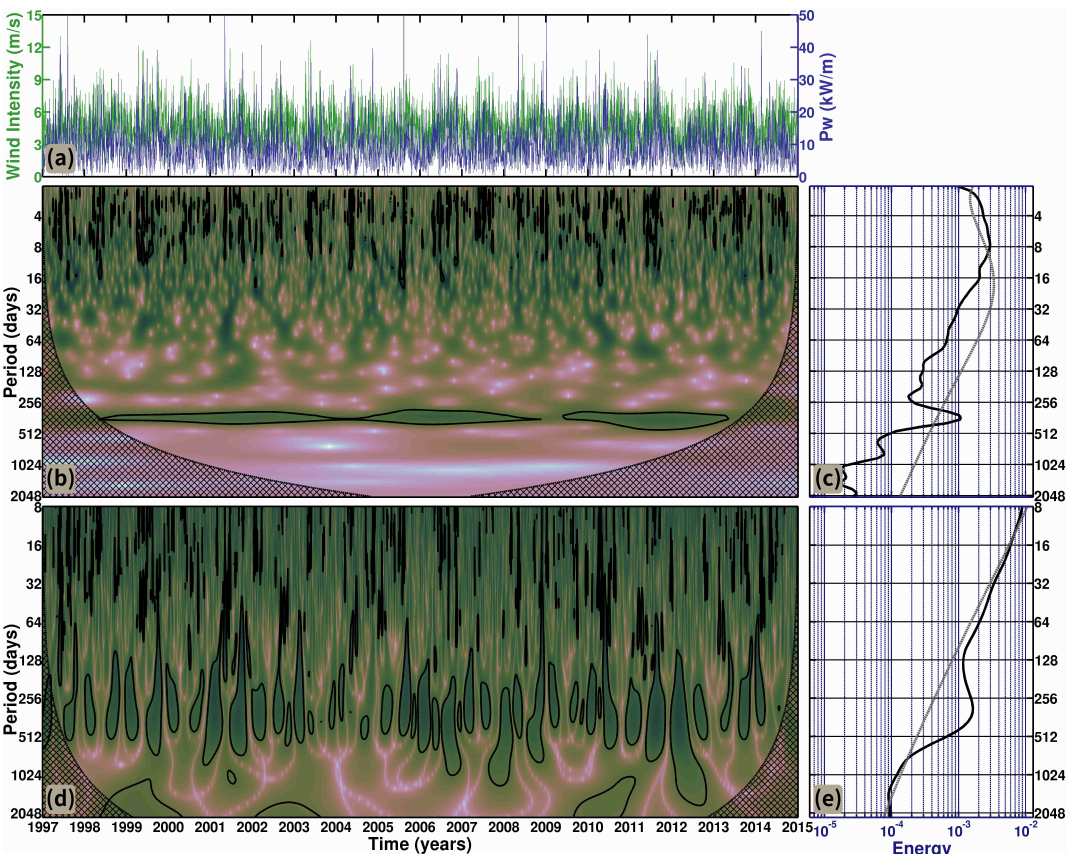
Figure 11. ( a ) Time series of wind intensity (blue) and P w (green) used for the cross-wavelet analysis. ( b ) Local Morlet wavelet power spectrum. Thick contour lines enclose regions of greater than 95% confidence for a red noise process with a lag1 coefficient of 0.7. Cross-hatched regions indicate the cone of influence where edge effects become important. ( c ) Global Morlet power spectrum of the time series and the dotted line indicate the 95% confidence level. ( d ) Mexican Hat local wavelet power spectrum. Thick contour lines enclose regions of greater than 95% confidence for a red noise process with a lag1 coefficient of 0.1. Cross-hatched regions indicate the cone of influence where edge effects become important and. ( e ) Global Mexican Hat power spectrum of the time series and the dotted line indicate the 95% confidence level on the coastal zone of Laguna. Cube Helix color scheme developed by Green